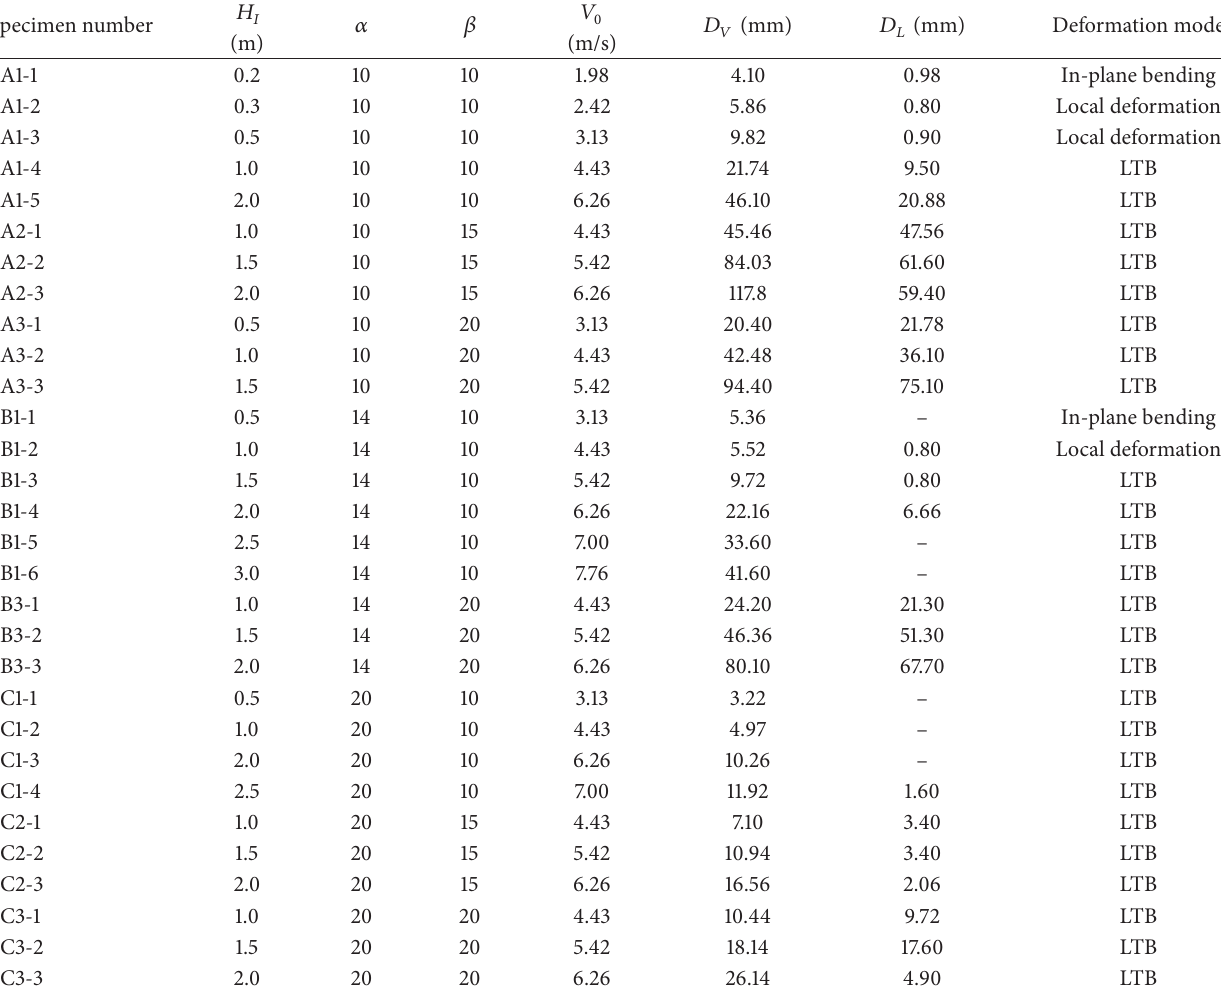
Table 2: Numbers and test results of specimens.